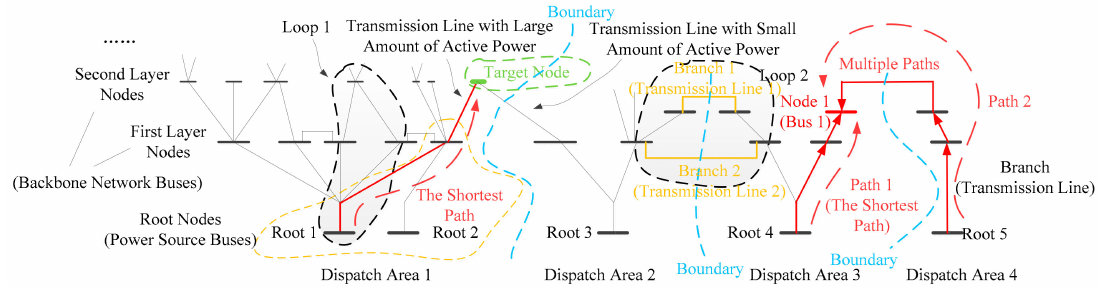
Figure 2. Schematic diagram of the breadth-first search (BFS)